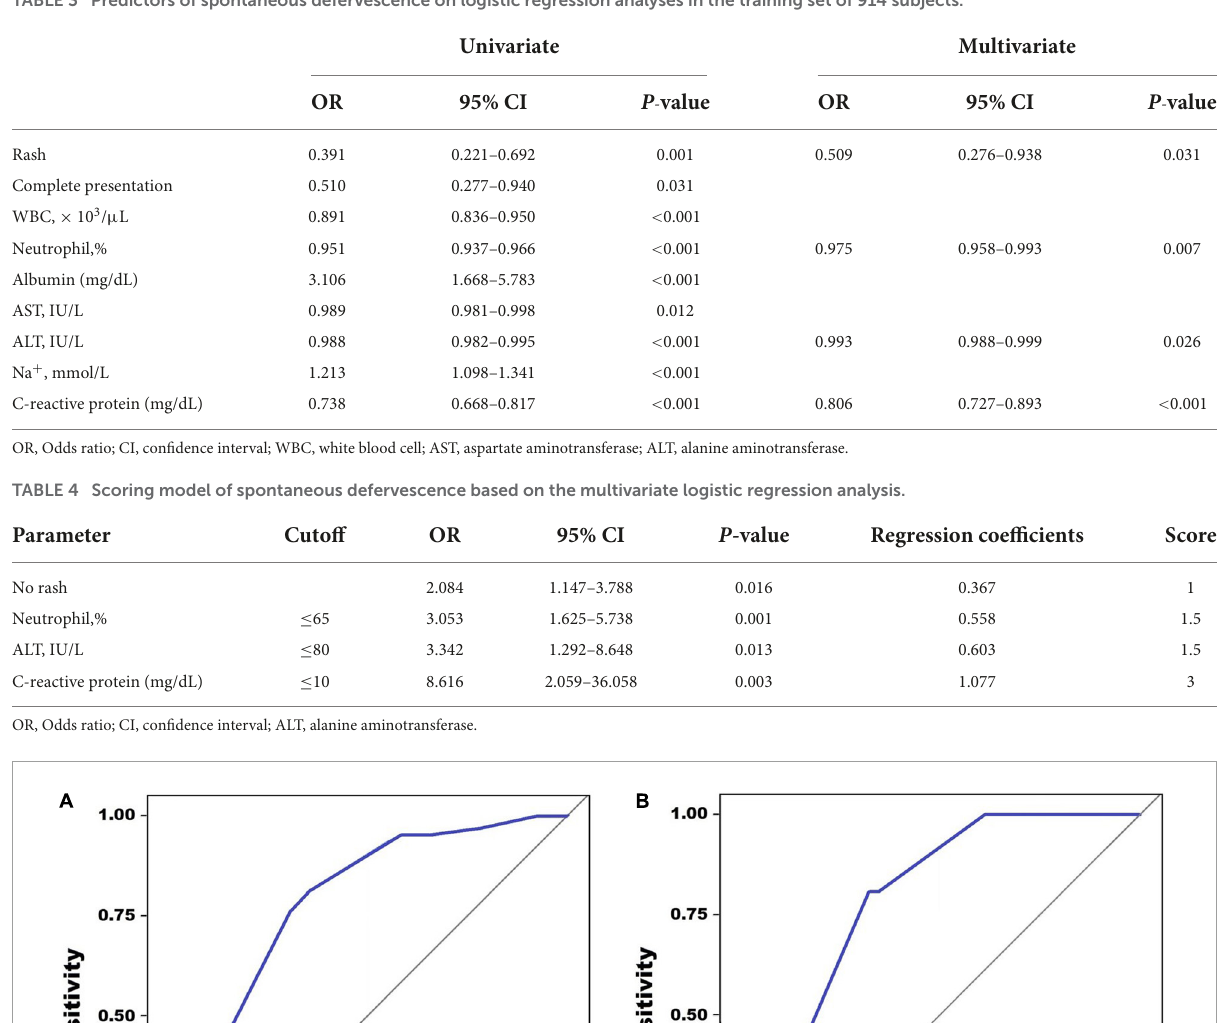
TABLE 3 Predictors of spontaneous defervescence on logistic regression analyses in the training set of 914 subjects.